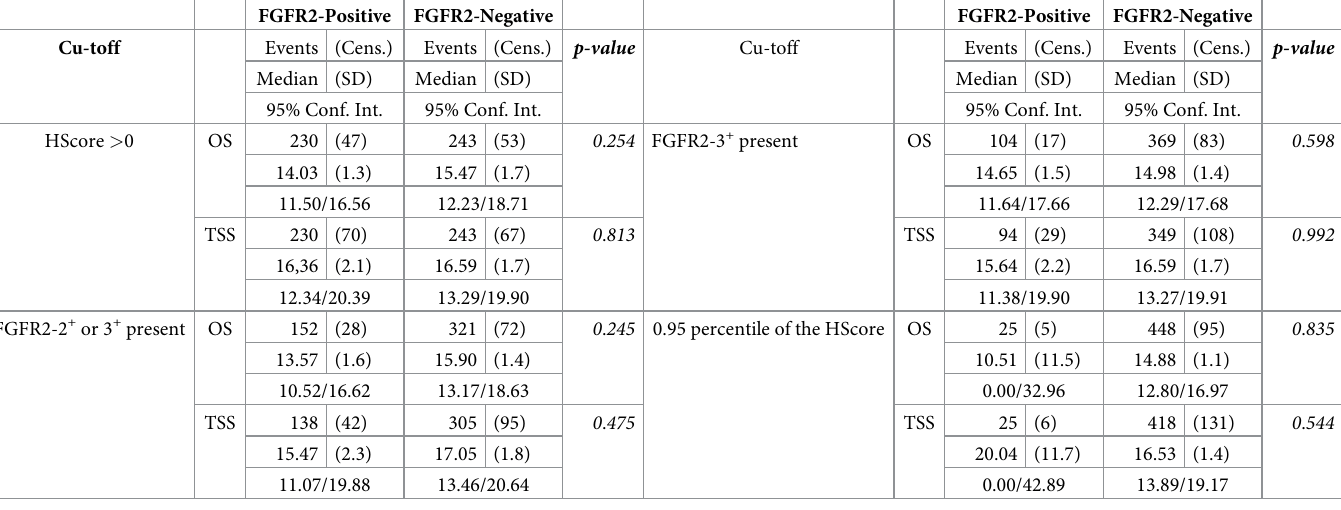
Table 2. Analysis of patient survival using different definitions of FGFR2 positivity. FGFR2-Positive FGFR2-Negative FGFR2-Positive